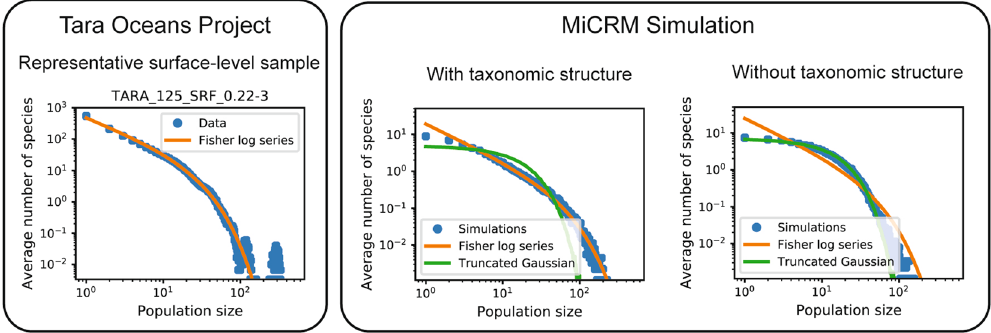
Figure 5. Metabolic and taxonomic structure give rise to Fisher log series Left: Tag sequence count distribution for a representative sea surface sample from the Tara Oceans Project. Data was subsampled 300 times at a depth of 10,000 reads (out of 129,135 in the original sample), and species with 5 reads or less in the raw data were treated as extinct for the purpose of computing the Fisher log series parameters (see Methods). Right: Abundance distributions for simulated communities. 1,000 individuals were sampled from each of 900 simulated communities, with environments and colonization as described for the “Simple Environments” panel of Fig. 6 below. Each point is an average over all 900 communities of the number of species with a given number of individuals. All simulations were performed with the metabolic structure described in Fig. 4 above. The left-hand panel also incorporated taxonomic structure, with different families specializing in different resource classes, with specialization level q = 0.9. The right-hand panel did not have taxonomic structure ( q = 0), and consumption preferences for all species were sampled from the same Bernoulli distribution. Green curve (“Truncated Gaussian”) comes from assuming that species’ invasion fitness are sampled from a Gaussian distribution, and that population sizes for surviving species are proportional to the invasion fitness, while species with negative invasion fitness go extinct. See Methods for details.